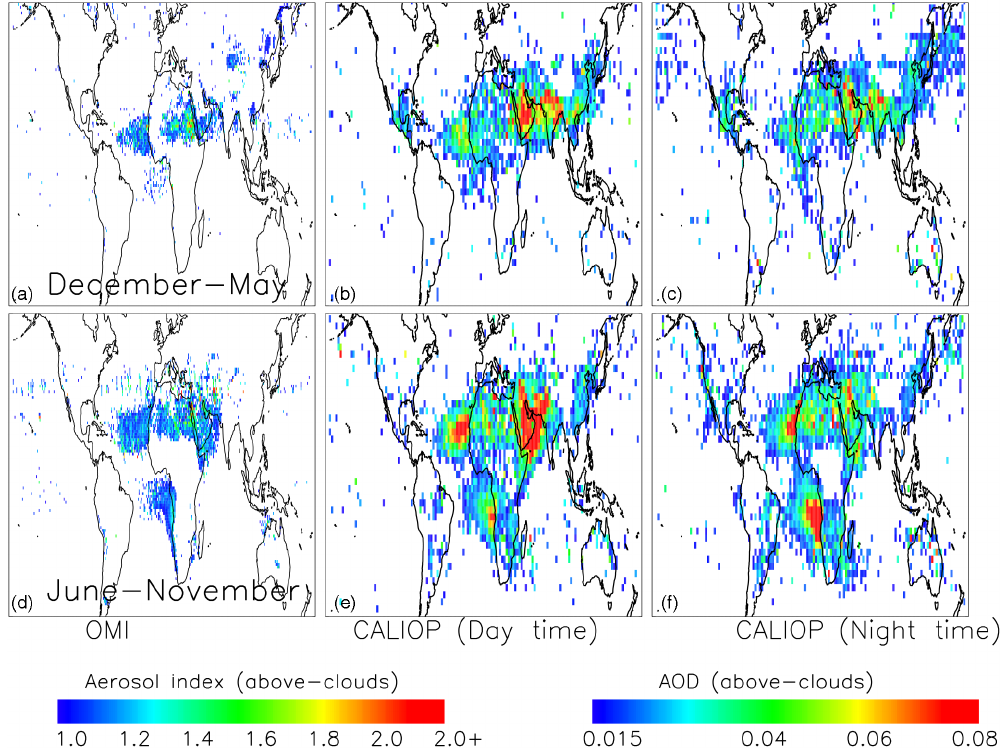
Figure 5. (a) Multi-year (2006–2013) daytime AI averaged into 1.0 ◦ × 1.0 ◦ bins constructed from collocated MODIS and OMI AI over strictly MODIS cloudy scenes during December through May. The averaged OMI AI is neglected below 1.0 in accordance with the AI ground floor determined in Fig. 2. (b) Multi-year (2006–2013) daytime ACAOD averaged into 2.5 ◦ × 2.5 ◦ bins derived from CALIOP cloud and aerosol layer products. Averaged CALIOP ACAOD values below 0.015 are considered below the noise floor for the study and thus are not shown. Panel (c) shows the CALIOP ACAOD similar to (b) except for nighttime observations. Panels (d–f) show the same information as (a–c) but during the summer and fall months